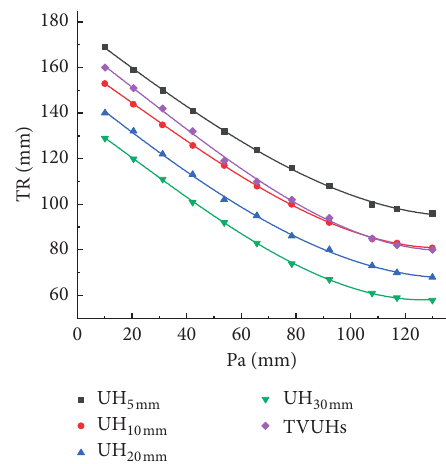
Figure 3: TR-Pa curves ( D �